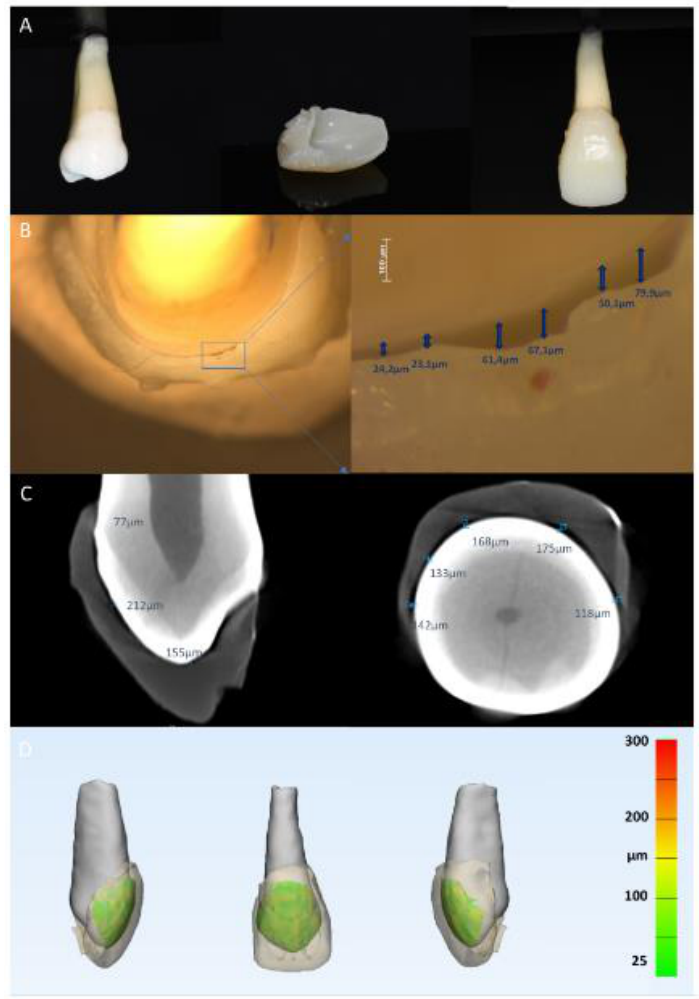
Figure 2. 3D printed veneer and evaluation methods. ( A ) 3D printed veneer and fitting to premolar; ( B ) evaluation of veneer seating using stereomicroscopy; ( C ) internal gap evaluation using micro-computed tomography, D: quantitative analysis of gap thickness.